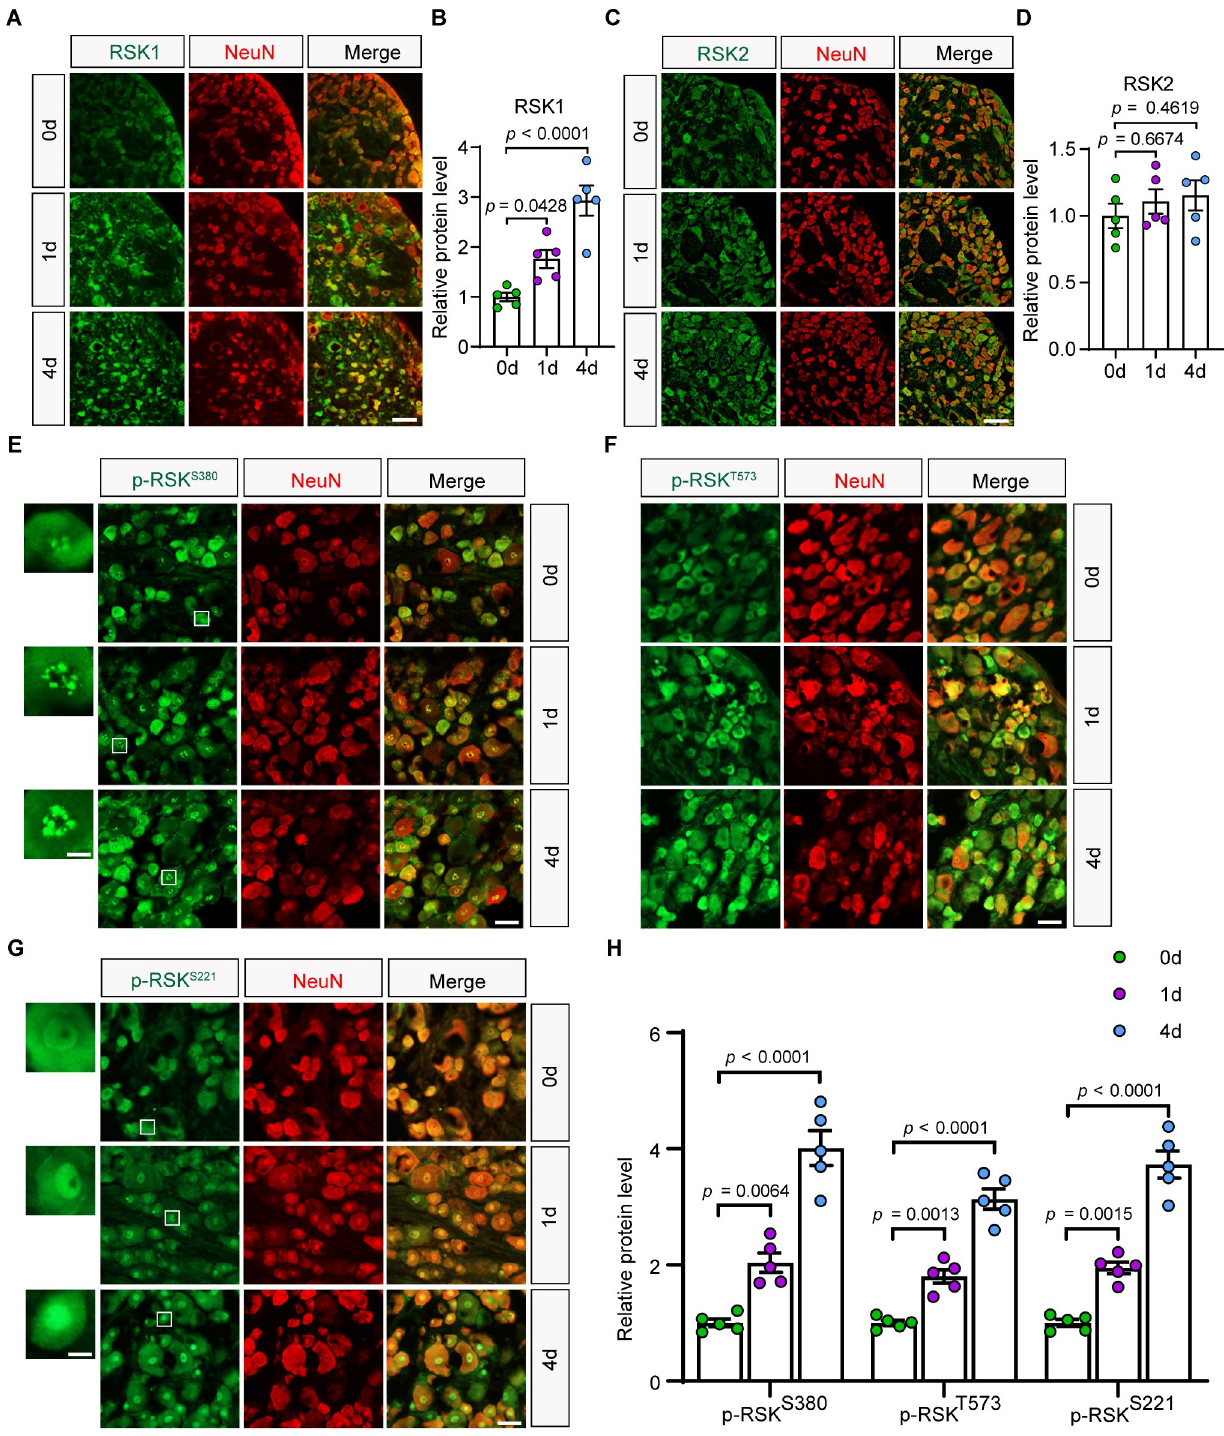
Fig 2. RSK1 expression and phosphorylation are up-regulated in DRG neurons following sciatic nerve axotomy. (A, C) Representative fluorescence images of immunostaining for RSK1 (A) and RSK2 (C) in the DRG on day 0, 1, or 4 post-SNI. Scale bar, 100 μ m. (B, D) Quantification of RSK1 (B) and RSK2 (D) immunofluorescence intensity relating to (A) and (C), respectively. Relative protein expression levels were quantified after normalization to background immunofluorescence (secondary antibody only) (mean ± SEM, 1-way ANOVA, Dunnett post hoc test, n = 5 biologically independent animals/group). (E–G) Representative fluorescence images of immunostaining for p-RSK S380 (E), p-RSK T573 (F), and p-RSK S221 (G) in the DRG on day 0,